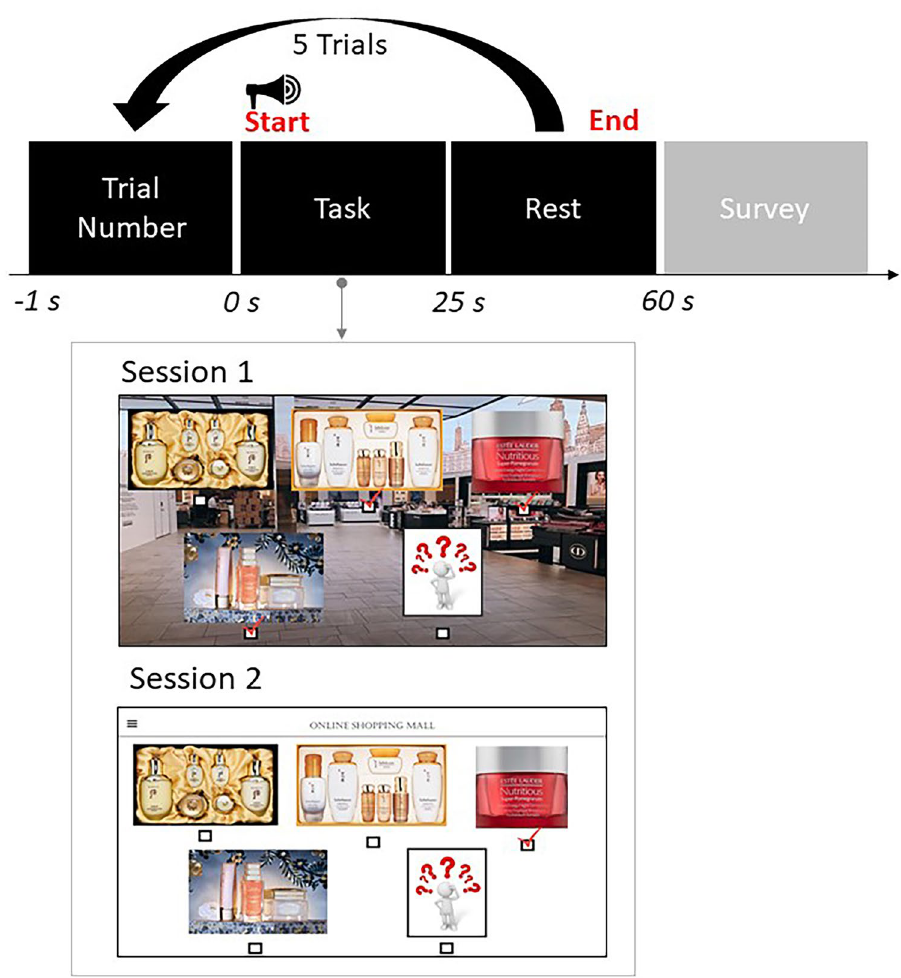
Figure 2. Schematic illustration of the experiment protocol. We instructed the participants to perform Session 1 (the task of shopping at online duty-free shops) and Session 2 (the task of shopping at online shops). After the experiment, a self-reported measurement was